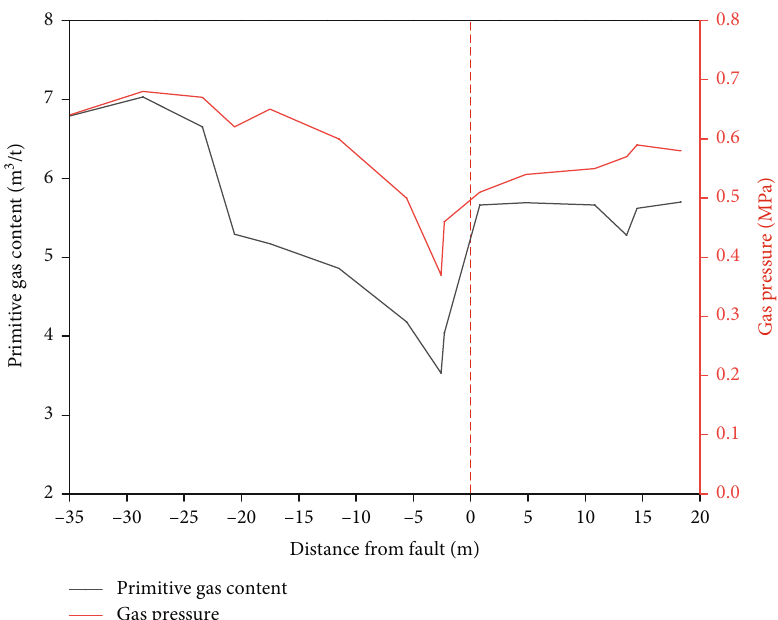
Figure 6: Relationship diagram of original gas content and gas pressure at di ff erent distances from measuring point to fault in heading face of 13817 return airway.